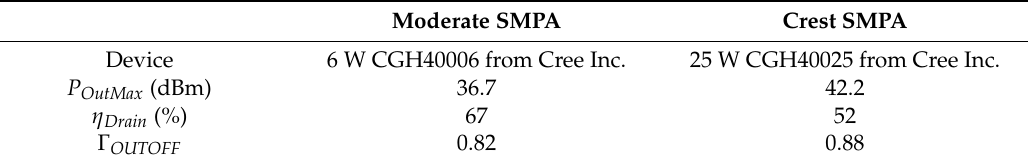
Figure 5. Standalone SMPAs and connected SMPAs and their drain efficiency equations. Table 1. SMPA